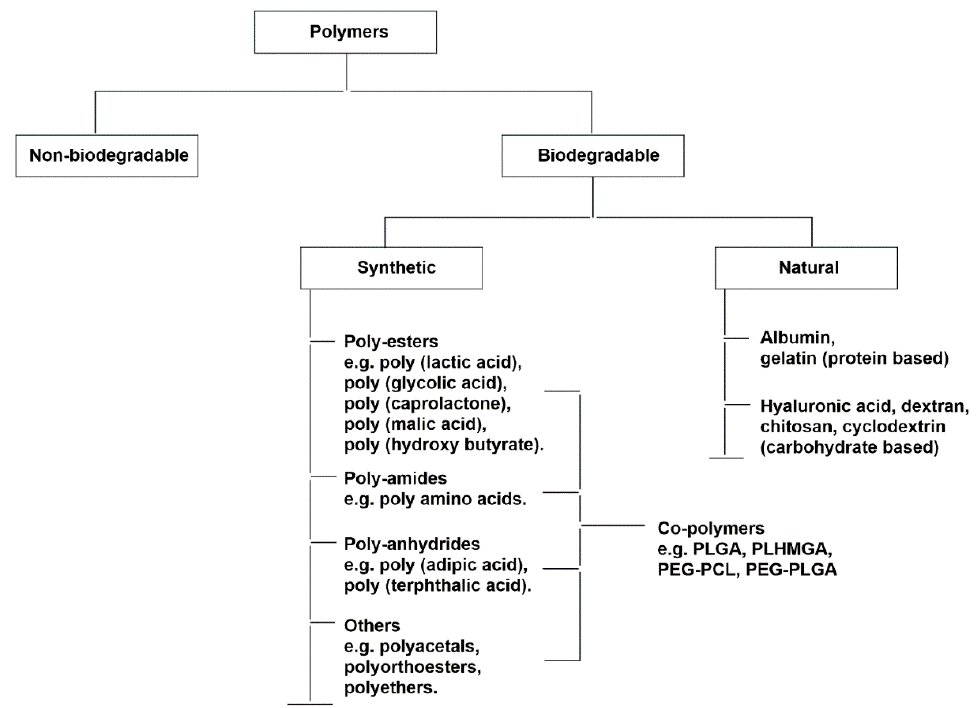
Figure 2. Polymers used in vaccine delivery.